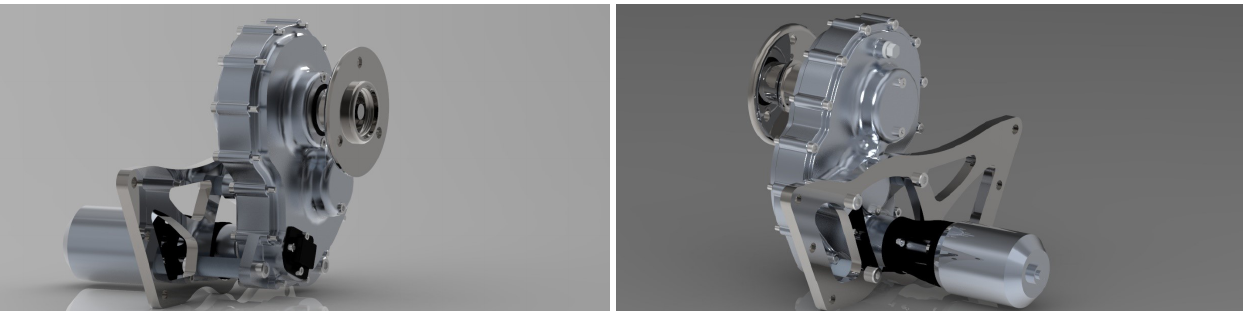
Figure 20. Drivetrain module of the